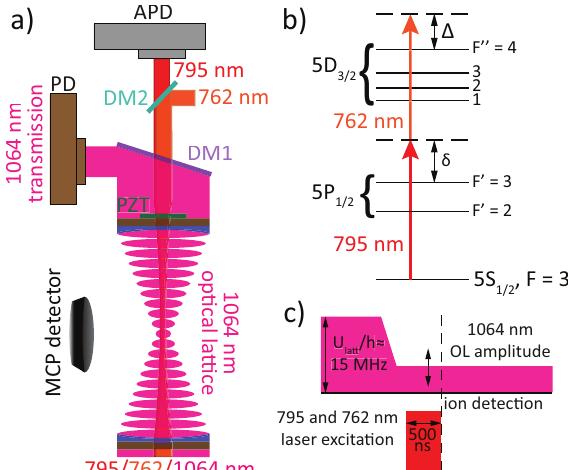
Figure 1. (Color online) Outline of experimental setup ( a ), utilized laser excitation scheme (not to scale) ( b ), and timing sequence of laser excitation and photoionization ( c ). “APD” avalanche photo-detector; “PD” photo-diode; “DM” dichroic mirror; “PZT” piezo-electric transducer. See text for